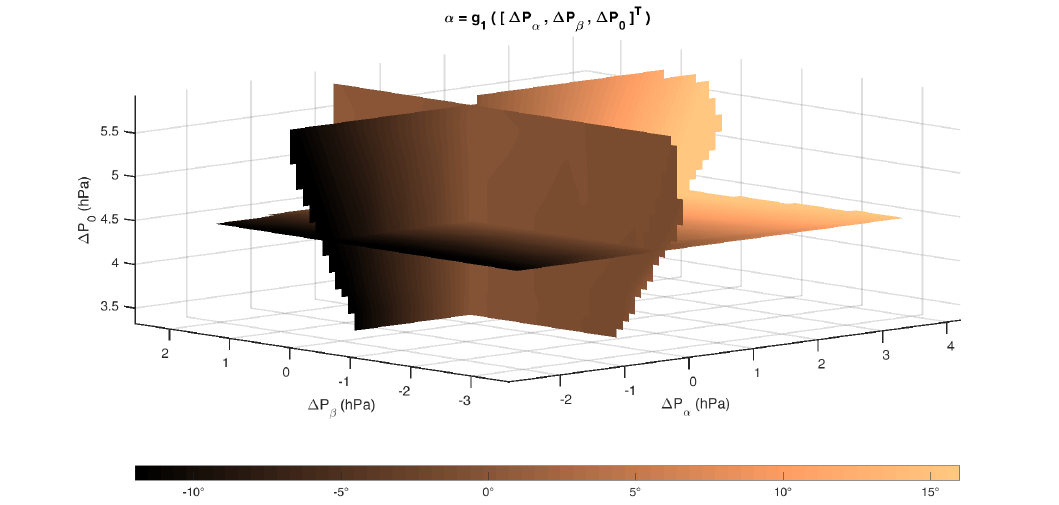
Figure 8. One of the three inverted volumetric calibration data fields (hyper-surfaces) to retrieve dynamic pressure and flow angles out of MHP pressure measurements. Here, slices through the hyper-surface for the angle of attack depending on the three pressure measurements ∆ P α , ∆ P β and ∆ P 0 are shown. Dark colors represent negative angles of attack, whereas light colors represent positive angles of attack. Color coding is shown through the color bar below the